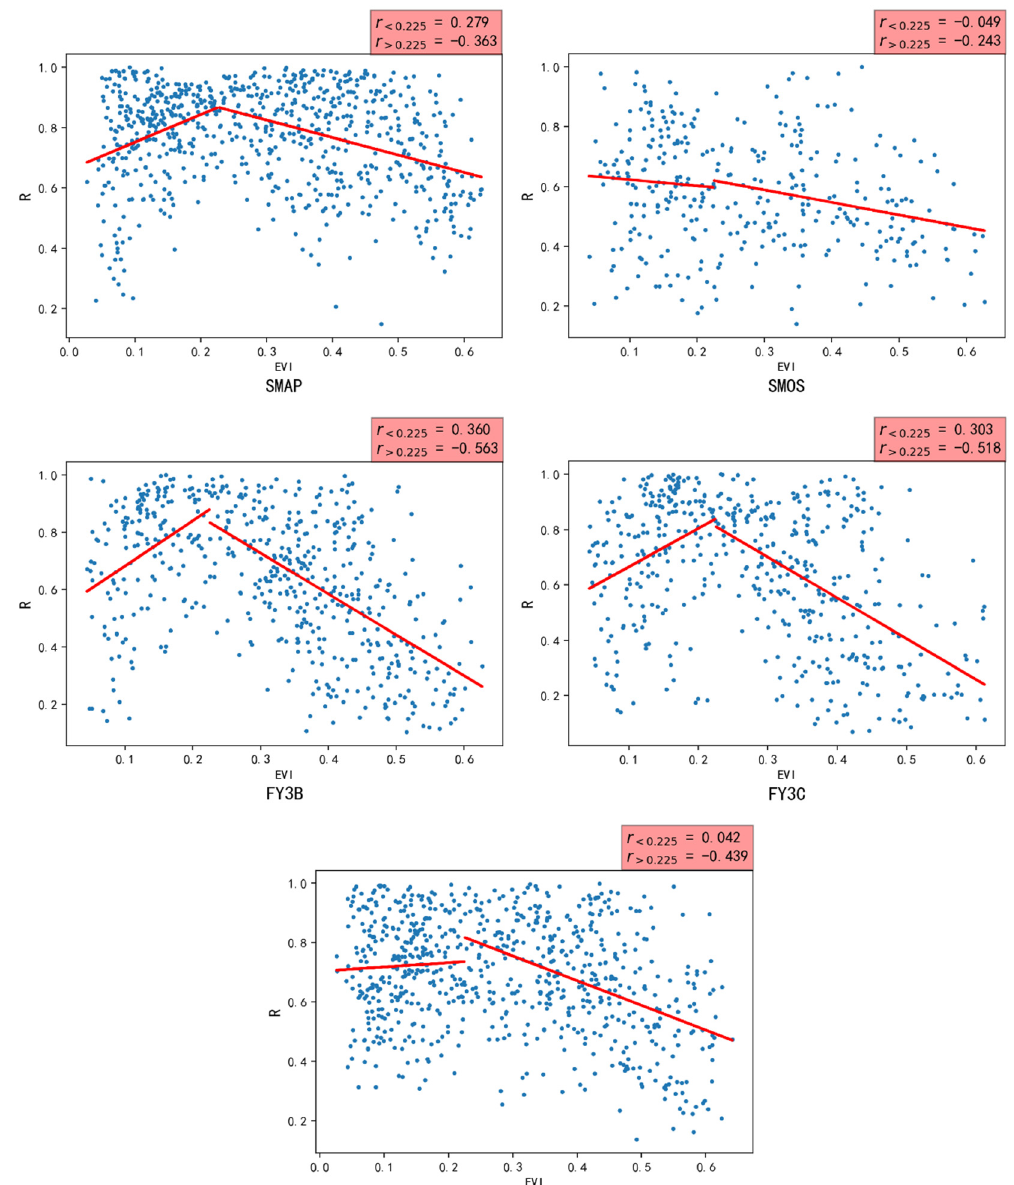
Figure 11. Scatterplots of the TC correlation between the EVI, and soil moisture obtained from SMAP, SMOS, FY3B, FY3C, and AMSR2 passive satellite data.